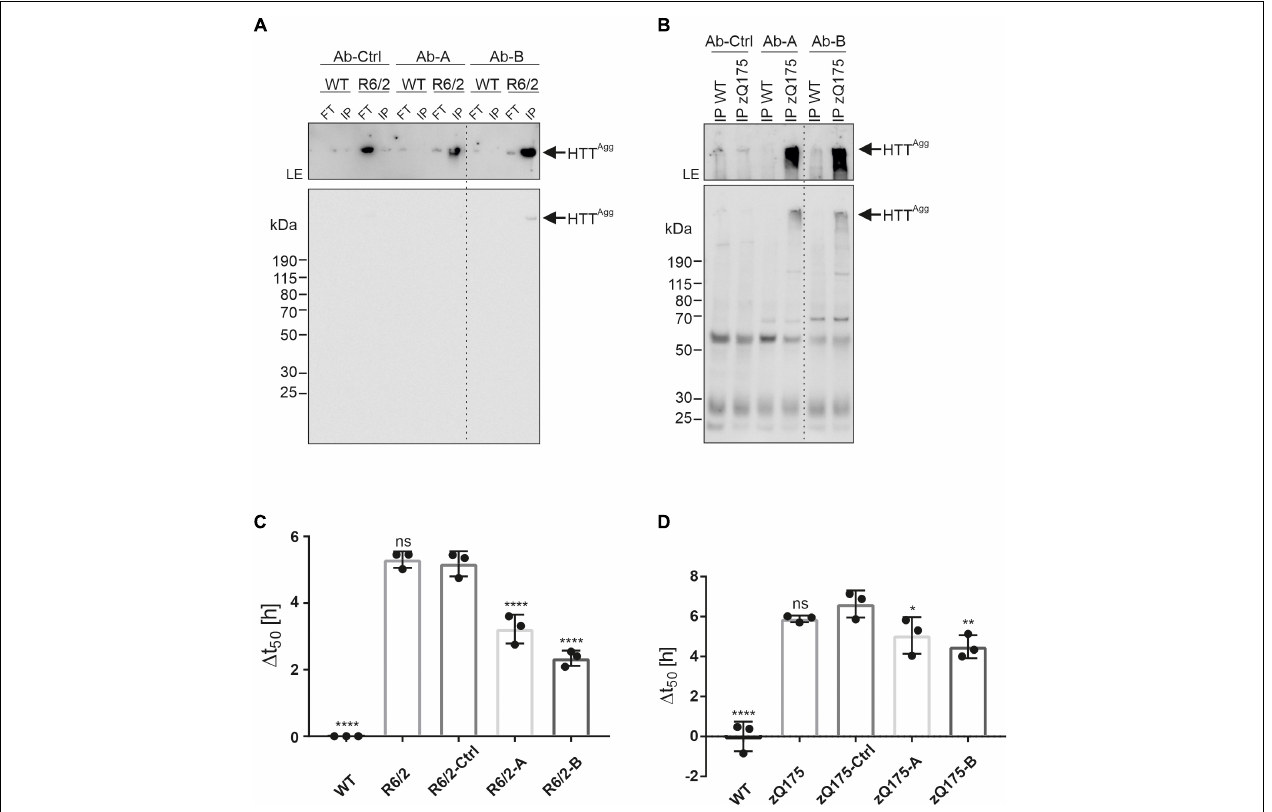
FIGURE 5 | Enrichment of mHTT aggregates from mouse brain extracts using human anti-HTT antibodies. (A) The human HTT antibodies Ab-A and Ab-B and an isotype control (Ab-Ctrl) were used for immunoprecipitation of mHTT aggregates from WT and R6/2 brain homogenates. Immunoprecipitates (IP) and flow-through samples (FT) were analyzed by immunoblotting on a denaturing gel using MW8 antibody. The western blot was exposed for 5 s. To better visualize the aggregates in the gel pockets, the upper part of the blot was exposed separately for 5 min. LE, longer exposure. HTT Agg indicates mHTTex1 aggregates. (B) Antibodies Ab-A, -B, and -Ctrl were used for immunoprecipitation of mHTT aggregates from WT and zQ175 mouse brain homogenates. Immunoprecipitates (IP) were analyzed by immunoblotting on a denaturing gel using the PHP2 antibody. The western blot was exposed for 10 s. The upper part of the blot was exposed separately for 1 min. LE, longer exposure (C) Analysis of WT and R6/2 brain homogenates, and FT samples derived from immunoprecipitations using Ab-A (R6/2-A), Ab-B (R6/2-B), and Ab-Ctrl (R6/2-Ctrl) in the FRASE assay. (cid:49) t50 is displayed as mean ± SD of four technical replicates. Statistical analysis: One-way ANOVA followed by Dunnett’s multiple-comparisons test reveals a significant difference in (cid:49) t50 values between WT and R6/2-Ctrl (****), R6/2-A and R6/2-Ctrl (****), and R6/2-B and R6/2-Ctrl (****) samples. ****, adjusted (adj.) p value = 0.0001. (D) Analysis of WT and zQ175 brain homogenates, and FT samples derived from immunoprecipitations using Ab-Ctrl (zQ175-Ctrl), Ab-A (zQ175-A), and Ab-B (zQ175-B) in the FRASE assay. (cid:49) t50 is displayed as mean ± SD of four technical replicates. Statistical analysis: One-way ANOVA followed by Dunnett’s multiple-comparisons test reveals a significant difference in (cid:49) t50 values between WT and zQ175-Ctrl (****, adj. p value = 0.0001), zQ175-A and zQ175-Ctrl (*, adj. p value = 0.049) and zQ175-B and zQ175-Ctrl (**, adj. p value = 0.0091)